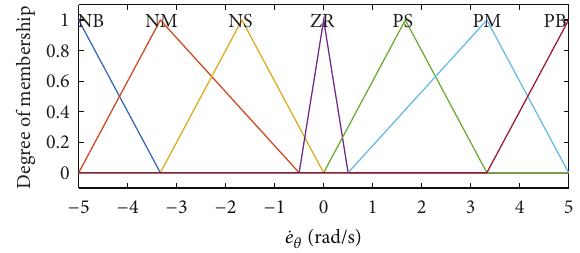
Figure 5: Angular velocity error membership